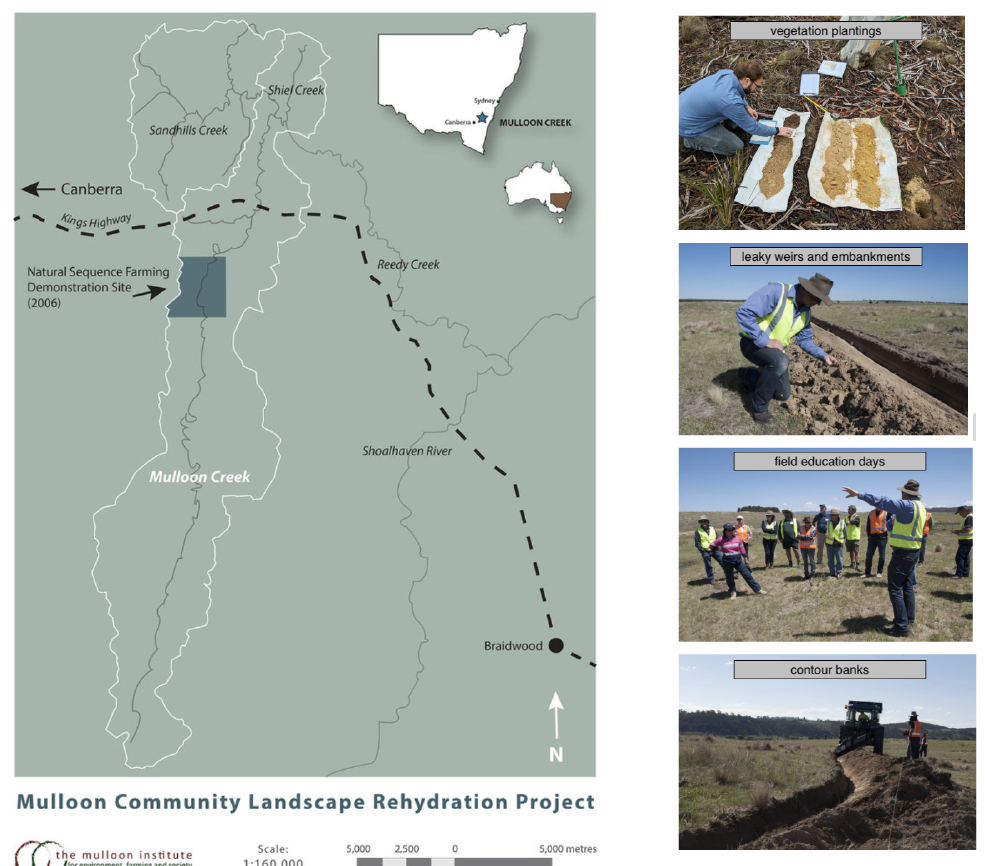
Figure 1. The Mulloon Creek catchment and land stewardship activities conducted by the Mulloon Institute (TMI), located near Braidwood in New South Wales. TMI focus on landscape rehydration activities, using Natural Sequence Farming. Activities include building leaky weirs, contour banks, embankments, and vegetation plantings, among others and have been linked to raising the water table, improving biodiversity, decreasing erosion, and building drought